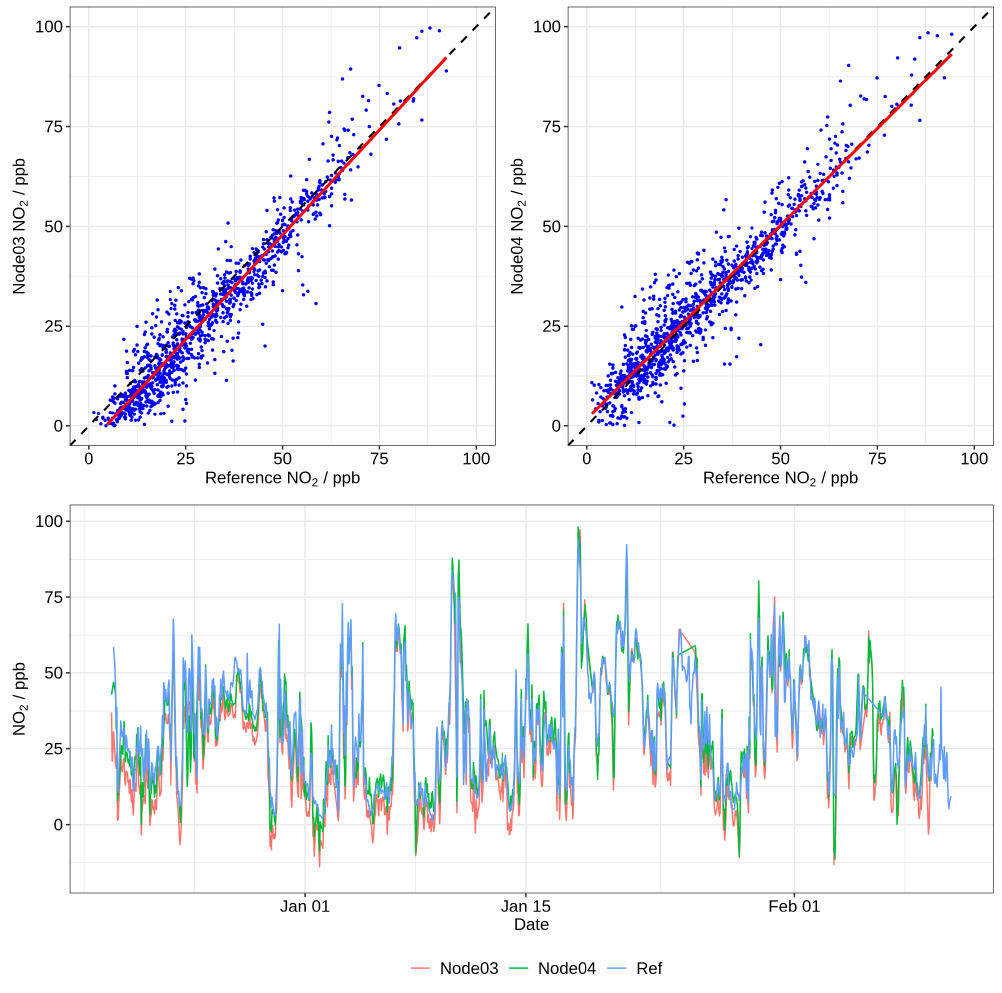
Figure 1. Correlation plots ( top ) for Node03 ( right ) and Node04 ( left ) versus reference measurements for the raw sensor output of NO 2 . A linear regression fit line (solid red line) and a 1:1 line (dashed black line) is shown in both panels. Time series plot (bottom) of two sensor nodes (Node03 and Node04) and reference air quality monitoring station. All data shown are 1 h average values. Table 2. Performance metrics for sensor output versus reference measurements for Node03 and